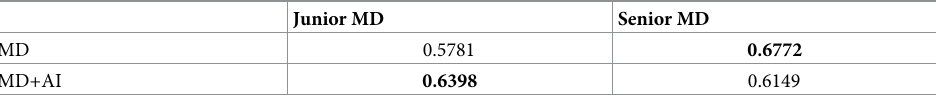
Table 4. AUC-ROC performance of the two different subject groups: Physicians without (MD) and physicians with (MD+AI) automatic decision support. The subject groups are divided into junior (less experienced) and senior